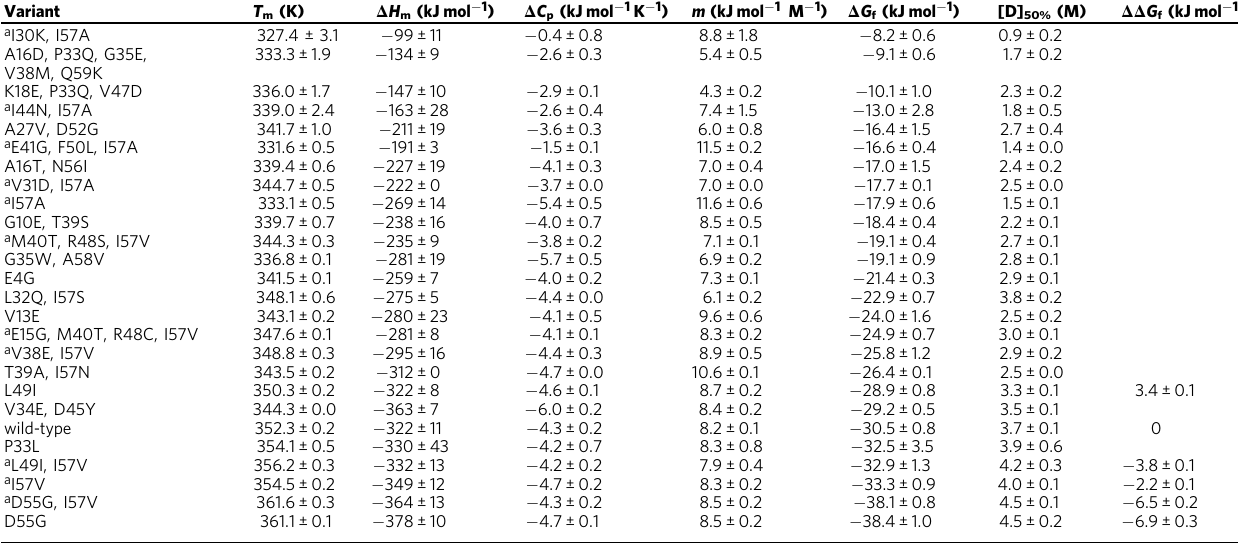
Table 1 Thermodynamic data for puri fi ed variants of CI2 identi fi ed with the folding sensor. Variant